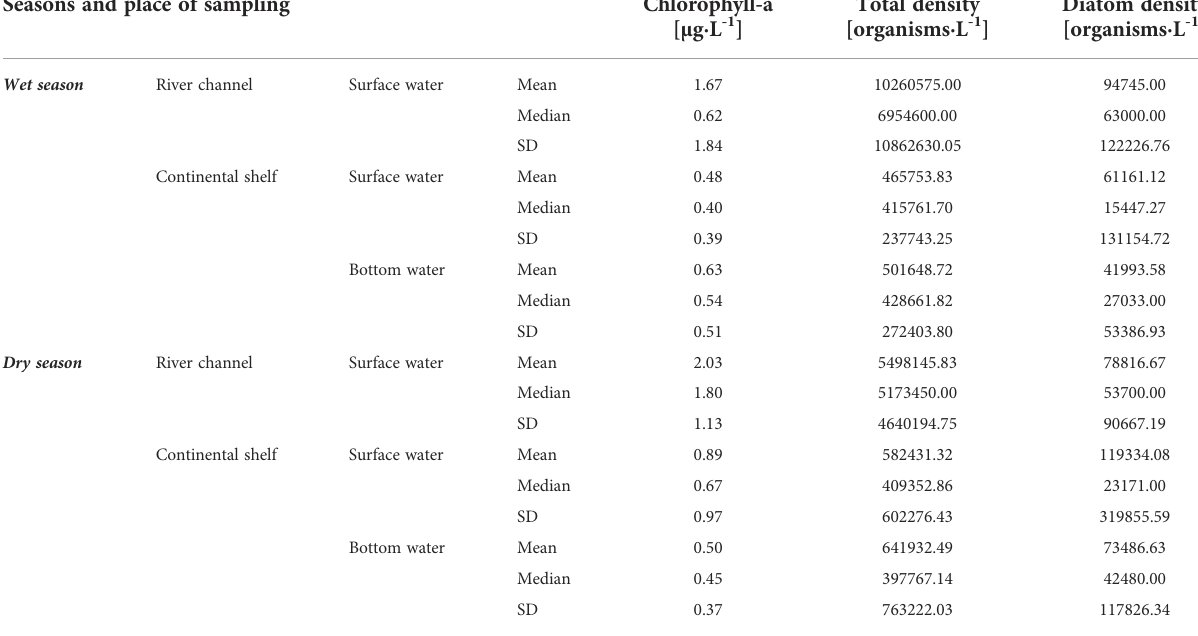
TABLE 3 Chlorophyll-a, Total phytoplankton density and total diatom density mean, median and standard deviation (SD) values in the Doce River channel and the continental shelf adjacent to the Doce River mouth. Seasons and place of